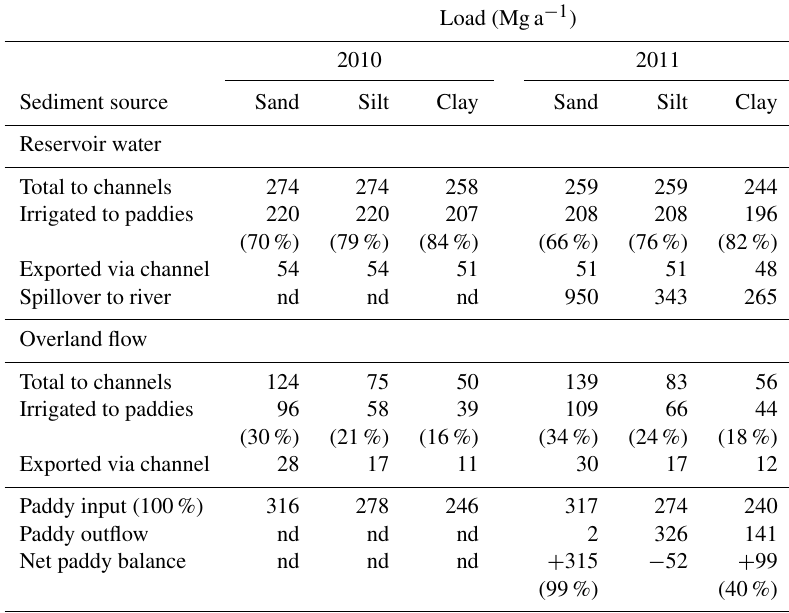
Table 4. Texture-specific sediment inputs from irrigation water and overland flow from the 37ha upland area in the subwatershed, and texture-specific sediment export and trapping by the 13ha paddy area (Figs. 1 and